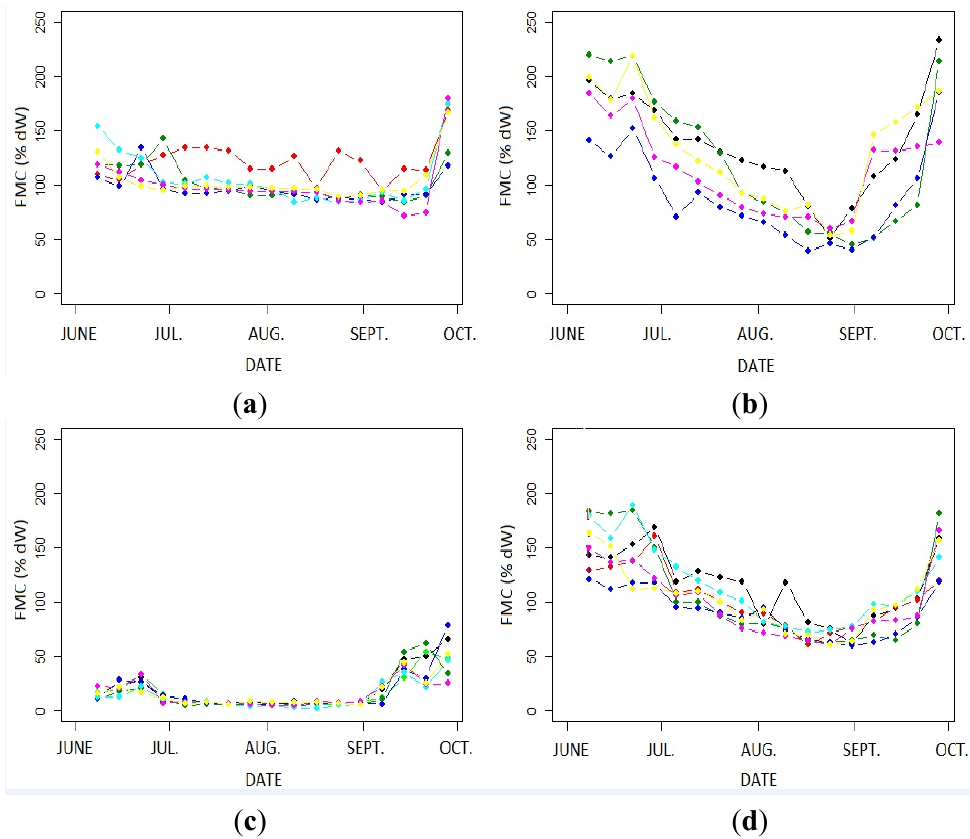
Figure 2. Weekly estimates of fuel moisture content (FMC) for ( a ) Quercus suber , ( b ) Cistus monspeliensis , ( c ) Litter, ( d ) Erica arborea and between June 1 and September 28, 2010, for study plots Ain Draham (black), Ain Snoussi (red), Beni Mtir (green), Fernana (blue), Hammam Bourguiba (cyan), Khroufa (magenta) and Tabarka